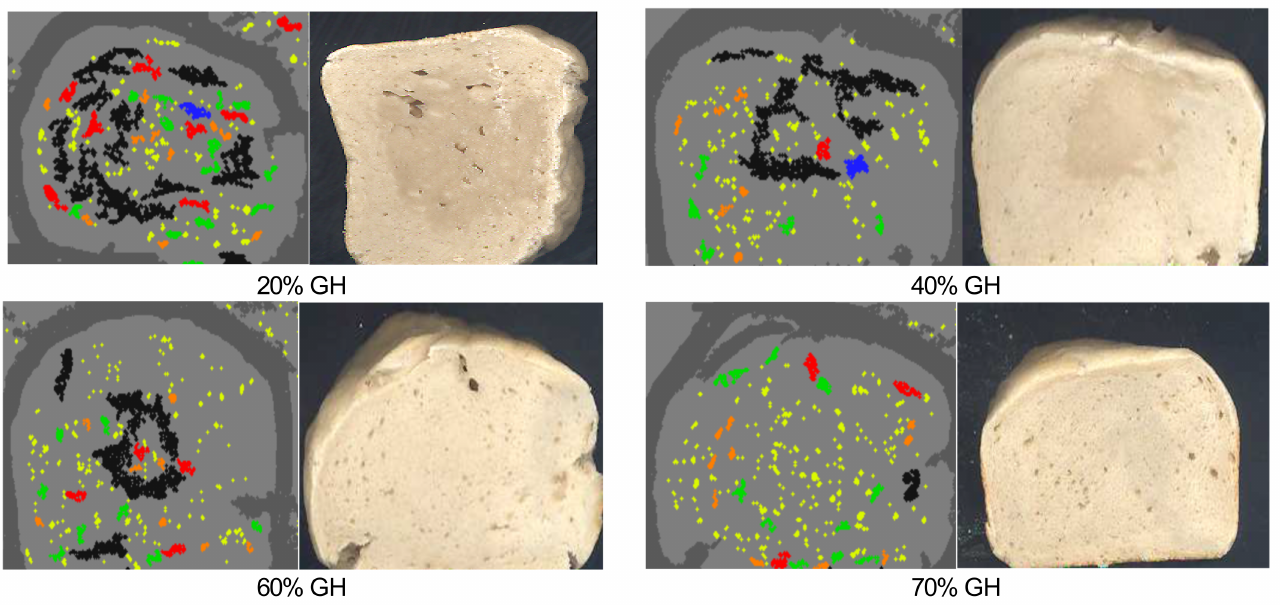
Figure 3. Pore size analysis of GH breads with promoters (20–70%). The figure shows the cross- sectional structure of the bread when breads are cut into thin slices for the GH range from 20% to